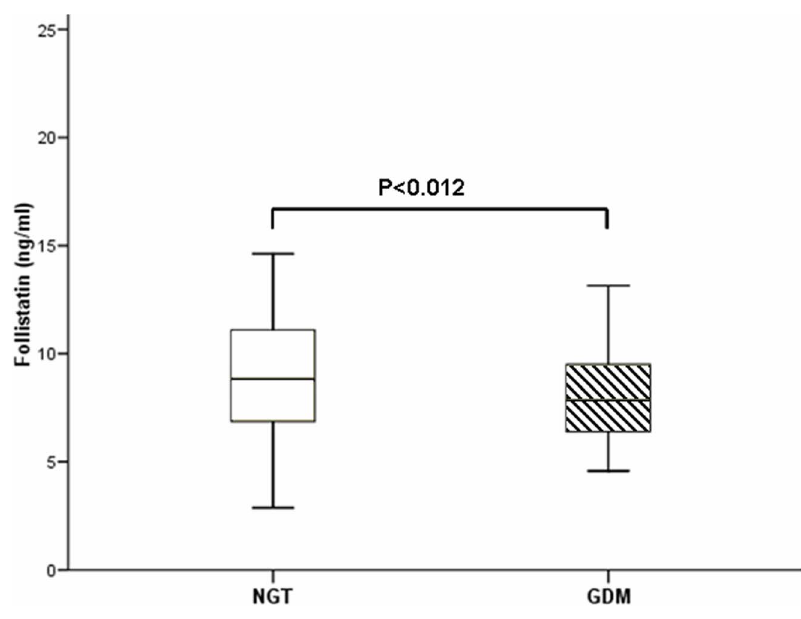
Figure 1. Serum follistatin levels in the NGT group compared with the GDM group.